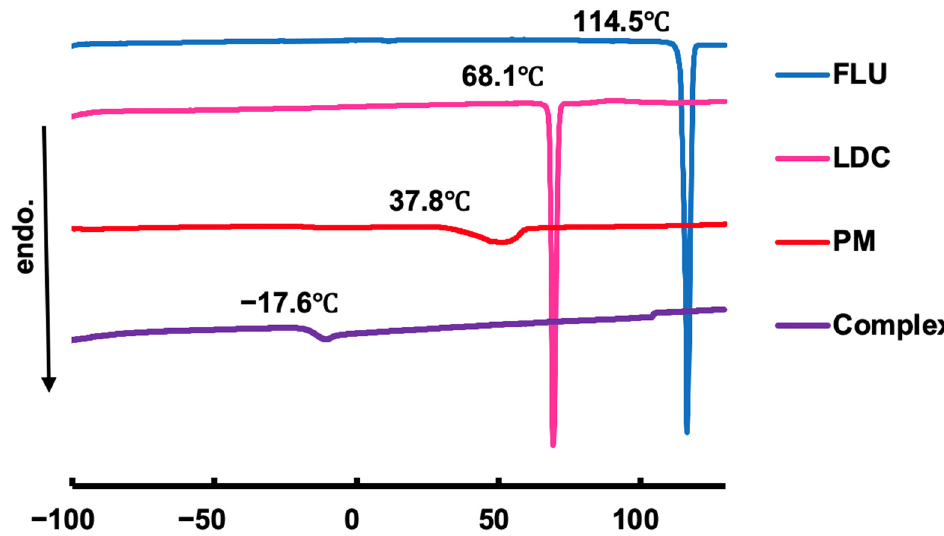
Figure 3. DSC profiles for the FLU, LDC, PM, and FLU/LDC complex.